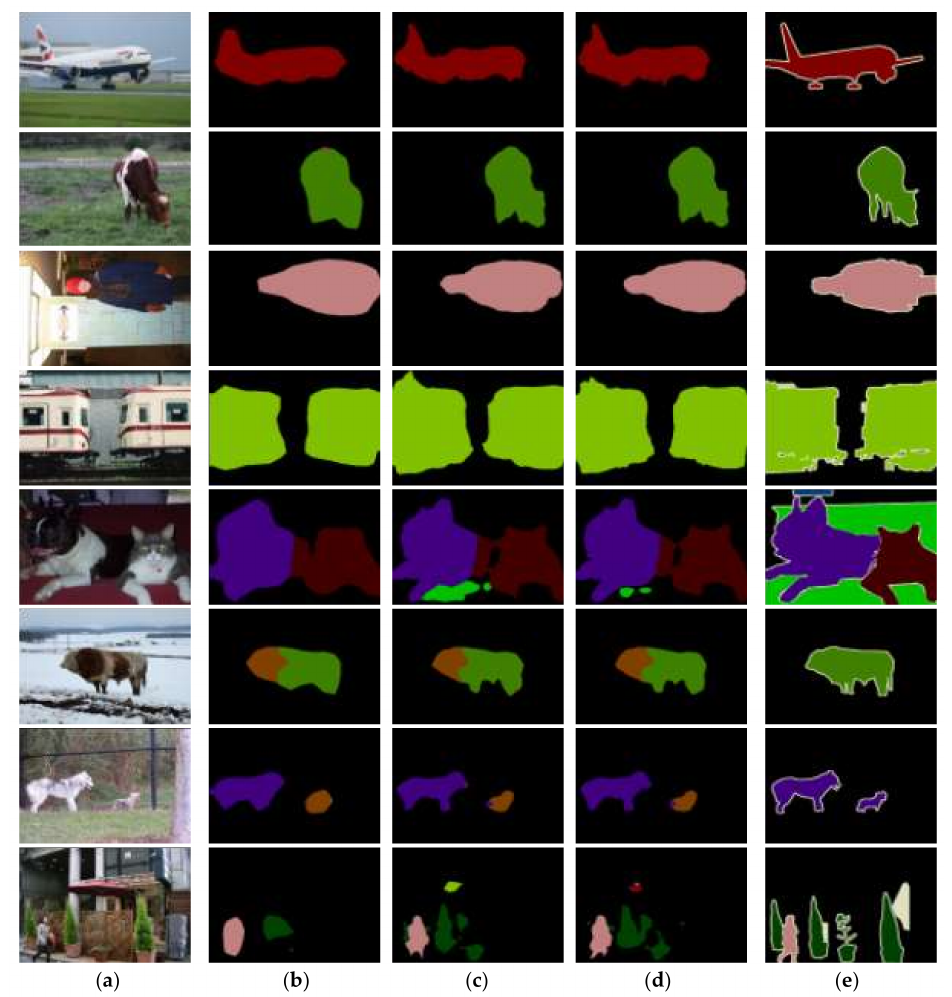
Figure 7. Comparison of original images, semantic segmentation results and ground truth. ( a ) Original images; ( b ) FCN-32s semantic segmentation results; ( c ) FCN-16s semantic segmentation results; ( d ) FCN-8s semantic segmentation results; and, ( e ) the ground